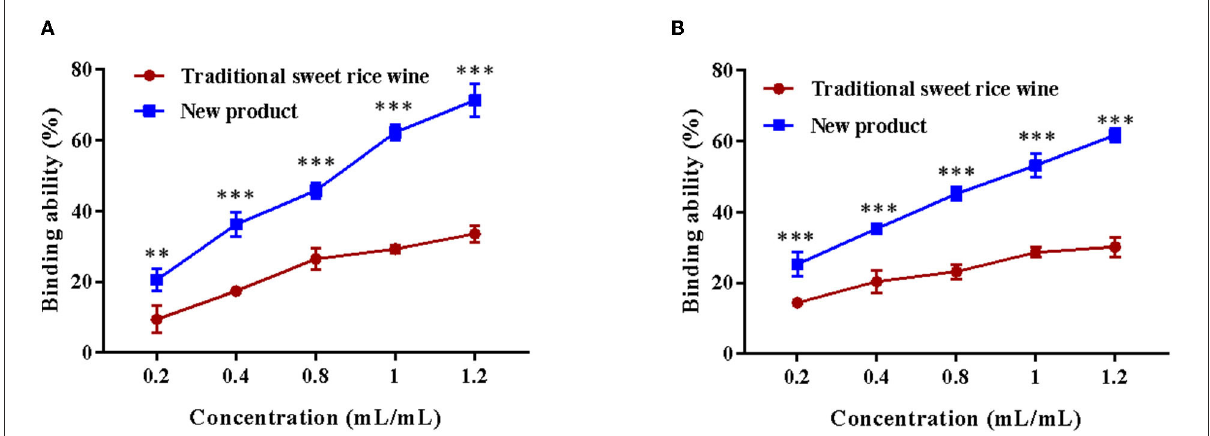
FIGURE8 Cholate binding ability of traditional sweet rice wine and new product. (A) Sodium glycocholate binding capacity, (B) sodium taurocholate binding capacity ( n = 3). ** p < 0.01; *** p < 0.001.